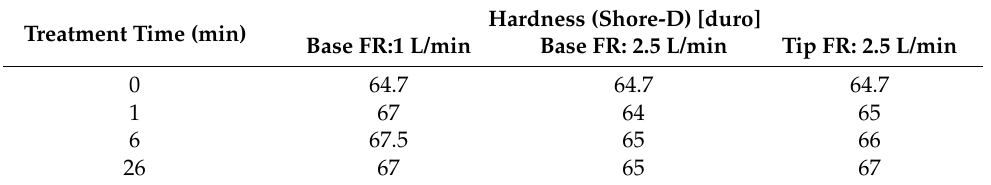
Table 3. Hardness measurements after 15 s of